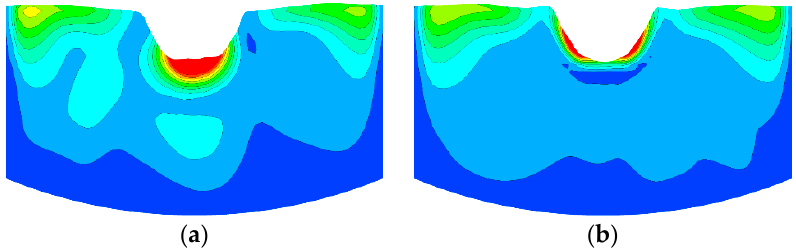
Figure 8. Simulated results of mean turbulent viscosity distributions. ( a ) With a swirler and ( b ) without a swirler.